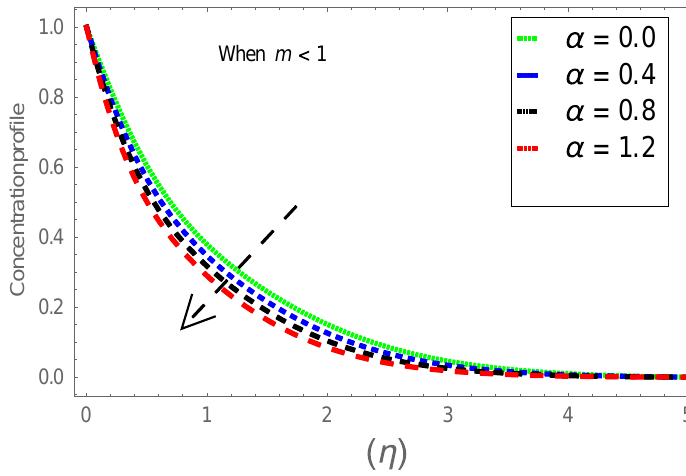
Coatings 2021 , 11 , x FOR PEER REVIEW